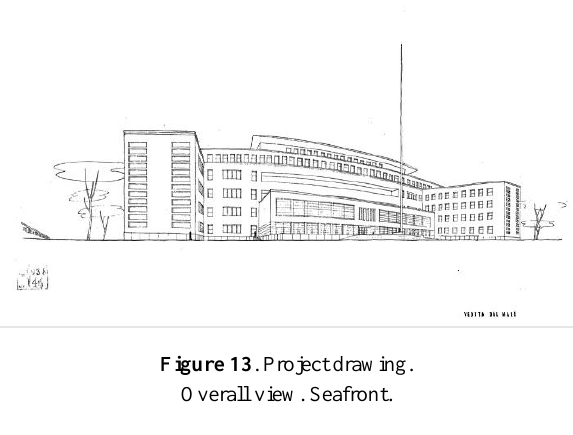
Figure 13 . Project drawing. Overall view.